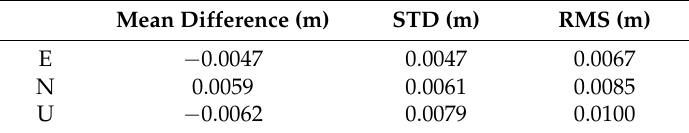
Table 2. The positioning difference with different baseline length between user and the VRS.